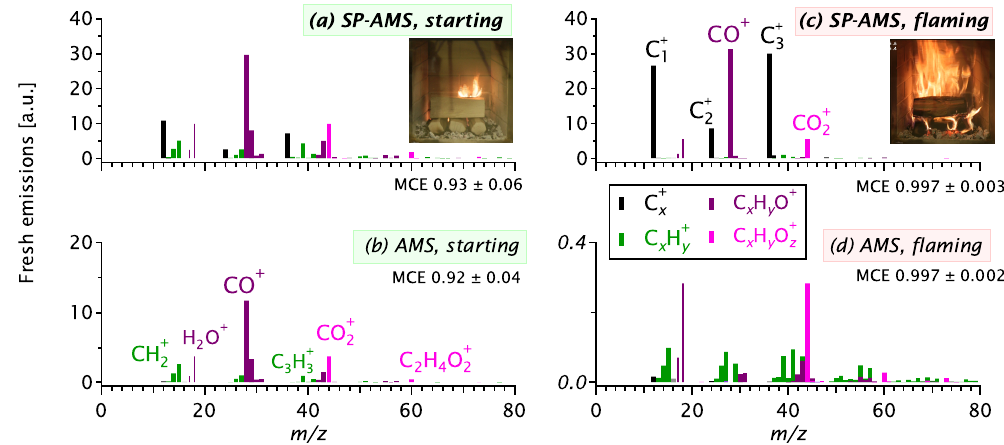
Figure 3. Fresh-emissions SP-AMS and AMS mass spectra for the starting-phase (highest OM emissions) and flaming-phase (lowest OM emissions, high BC emissions, Fig. 1) beech-combustion experiments. All signals have been scaled by representative RIEs. The estimated signals at O + , OH + , and H 2 O + have been estimated from CO + (Sect. 2.3) and therefore plotted with thinner bars. The insets show pho- 2 tographs of a typical burn. The mean and standard deviation of the MCE over the averaged period of time is included. Note the changes of scale in panels (c) and (d) . In panel (d) , no CO + signal is shown as that species was below its detection limit (2.4 units).